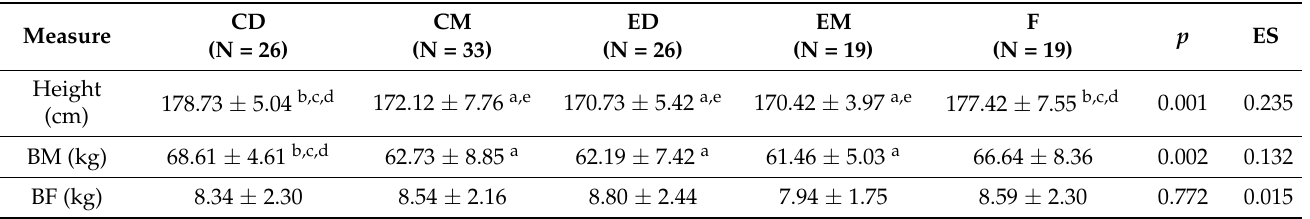
Table 3. Descriptive statistics (mean and standard deviation) for the athropometric outcomes between playing positions.